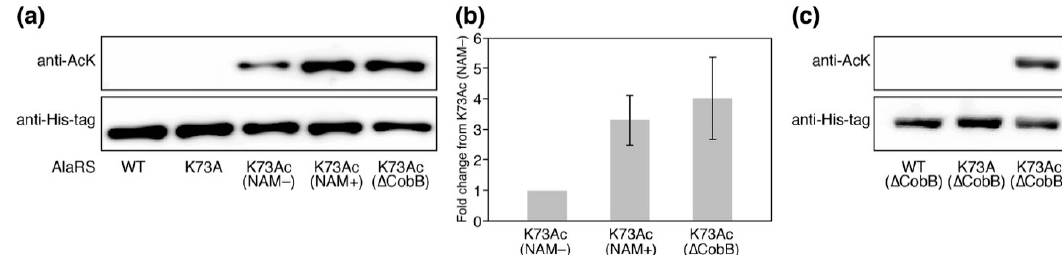
Figure 2. The verification of K73Ac-incorporation in AlaRS by Western blotting. ( a ) The acetylation levels of AlaRS variants were detected by Western blotting analysis using an anti- N ε -acetyl- L -lysine (AcK) antibody. Western blotting analysis using an anti-His-tag antibody showed the loaded protein control. NAM indicates nicotinamide. The data is representative of three independent SDS-PAGE and Western blotting assays. ( b ) Quantification of the band intensities of three independent Western blotting assays. The relative acetylation levels of K73Ac (NAM+) and K73Ac ( ∆ CobB) to that of K73Ac (NAM − ) were calculated. ( c ) Acetylation levels of the AlaRS wild-type (WT) and K73A mutant that were expressed under the same conditions as the K73Ac ( ∆ CobB) variant.